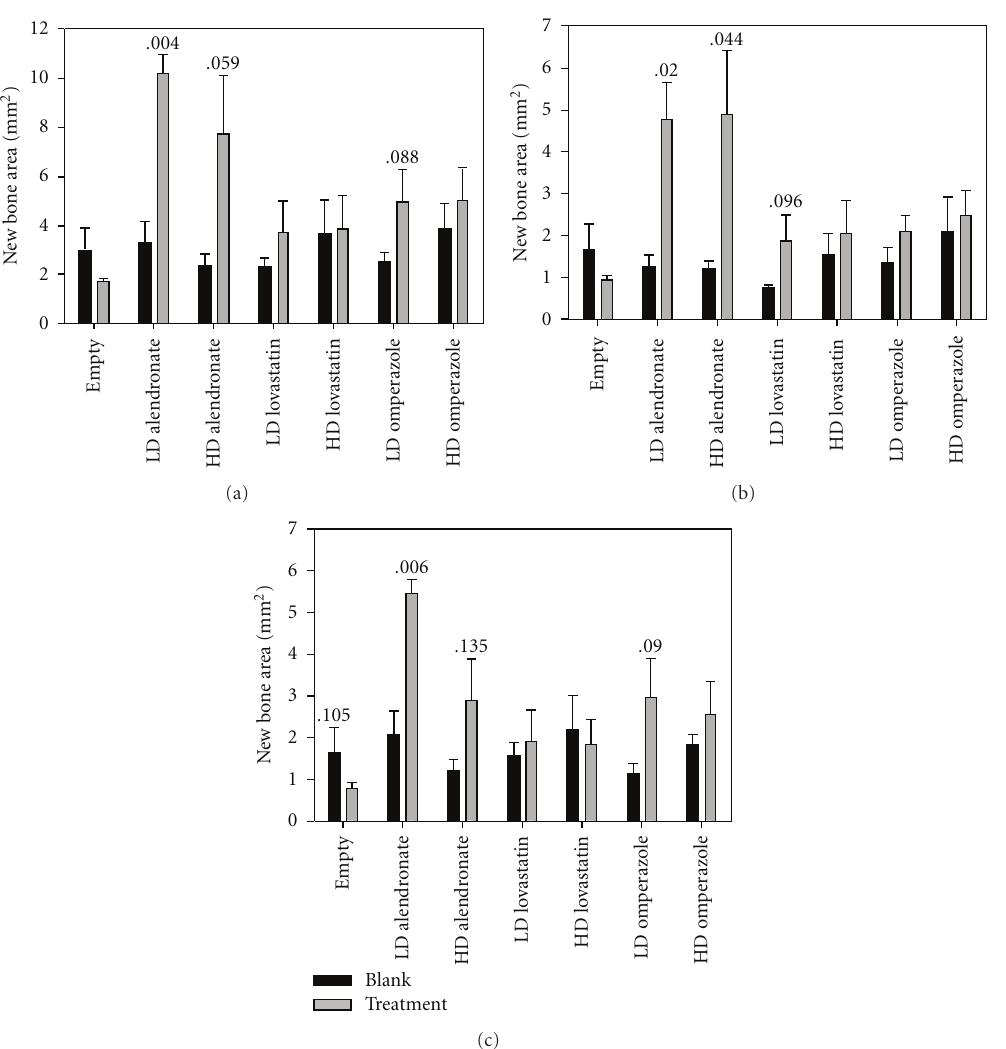
Figure 5: Histomorphometric Analysis of Bone Formation . Areas of new bone formation were measured from cross-sections of each femur defect. The total new bone area (a) was further categorized as being within the defect site and marrow space (b) or on the femur periphery (c). New bone area for each treatment group (gray bars) was compared to the new bone area in the contralateral, blank-treated femurs (black bars) for that group using Students t -tests. Significant P values are shown (low-dose, LD; high-dose,